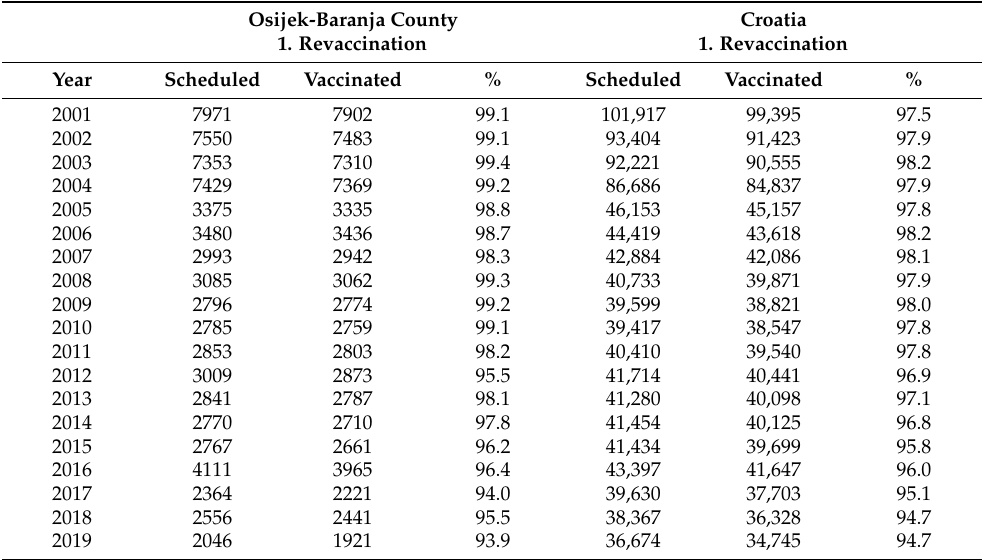
Table 2. Measles–rubella–mumps revaccination in Osijek-Baranja County and Croatia in years 2001 to